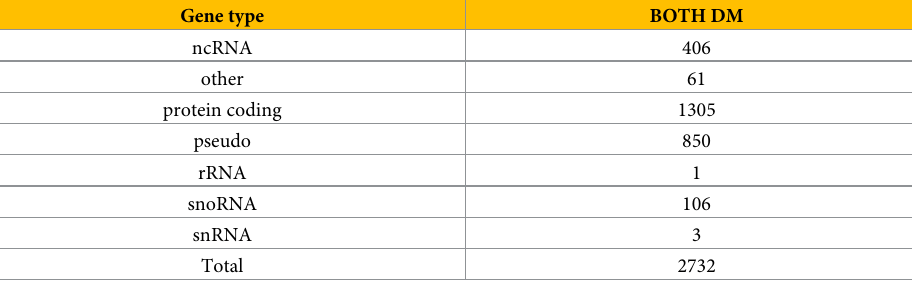
Table 2. Identification of gene